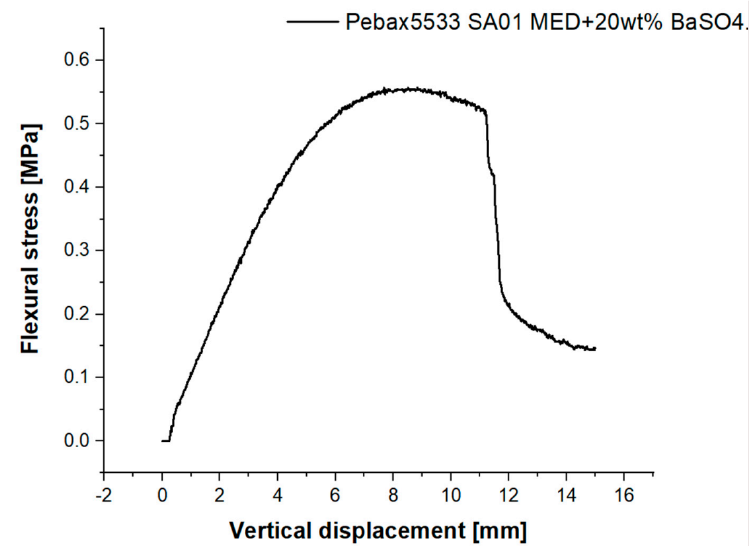
Figure 1. Flexural stress of the plastic stent shaft according to the vertical displacement.